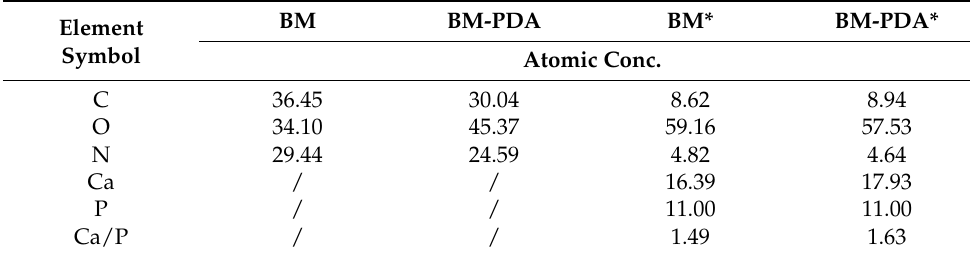
Table 2. Results of the EDX analysis.